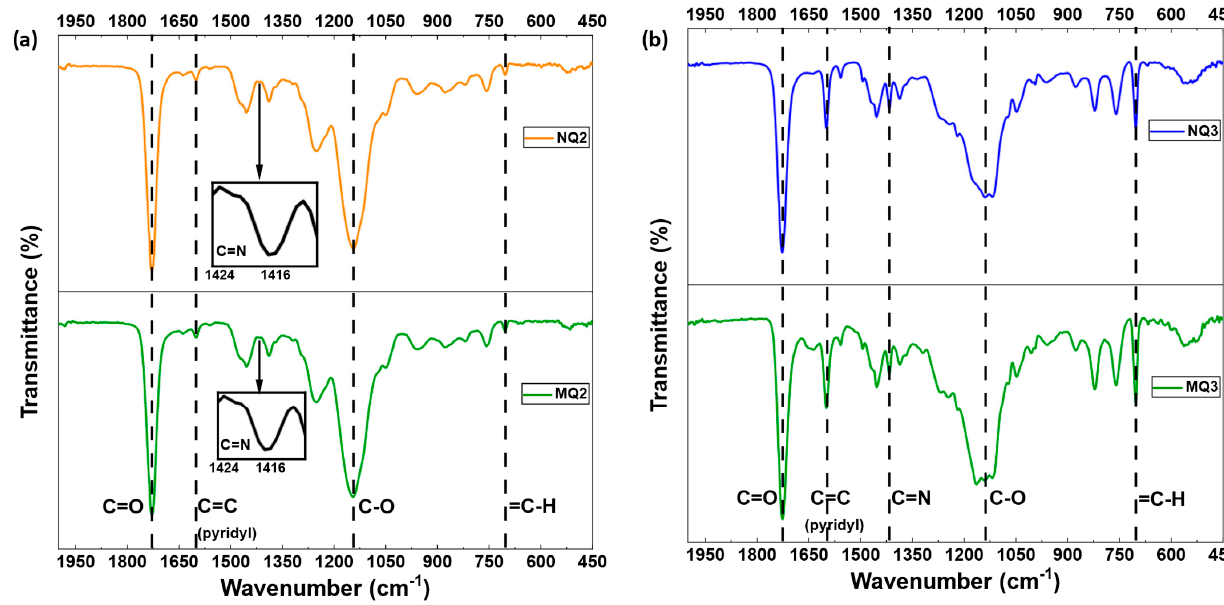
Figure 3. FTIR spectra of the 4VP − based MIPs. ( a ) MQ2/NQ2; ( b )